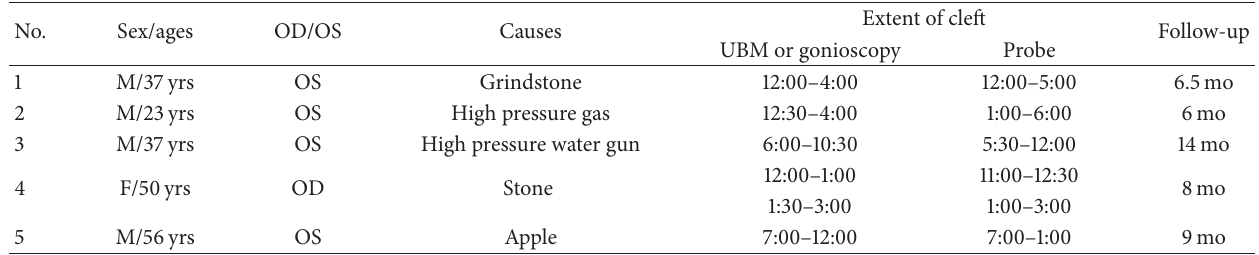
Table 1: General information on the five patients with cyclodialysis